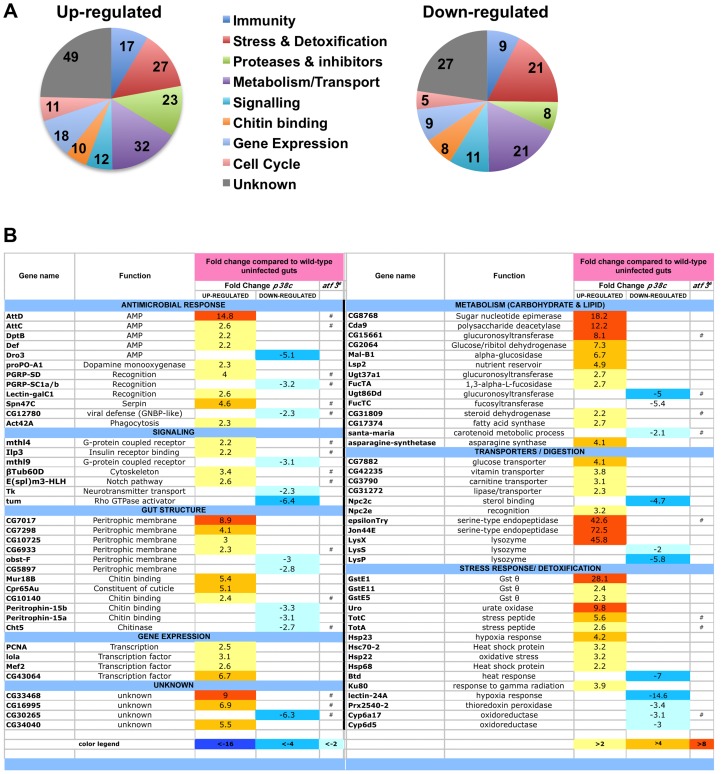
Genes involved in antimicrobial response, stress response, and metabolism are differentially regulated in p38c7B1 flies.(A) Proportion of up-regulated (left) and down-regulated (right) genes in different Gene Ontology categories. (B) A selection of genes differentially regulated in p38c7B1 fly guts (fold change compared to wild-type). Gene categories were determined by GO analysis on DAVID. Genes also affected in the atf376 mutant larvae as described in reference [33] are highlighted with an #. See Table S1 for complete list of genes.